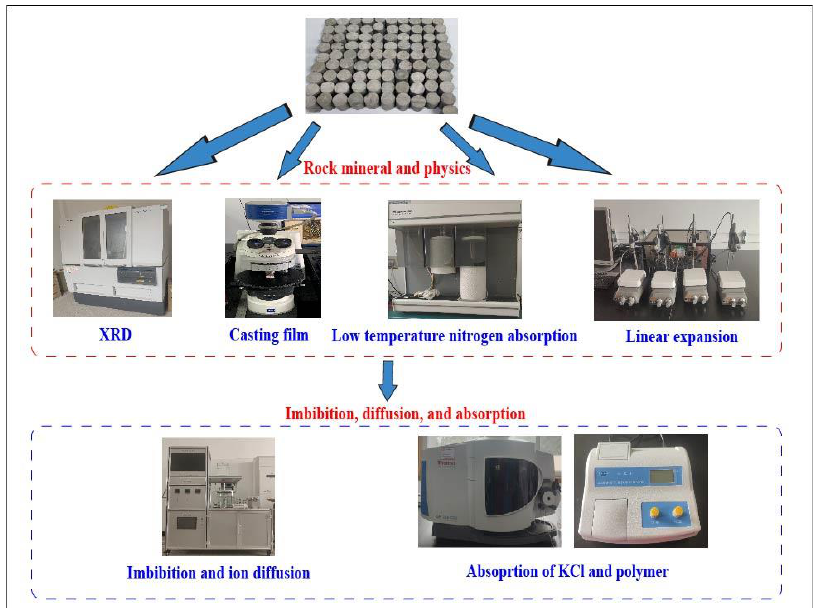
Figure 1. Experimental evaluation apparatus and schematic diagram for imbibition, ion diffusion, and adsorption properties.